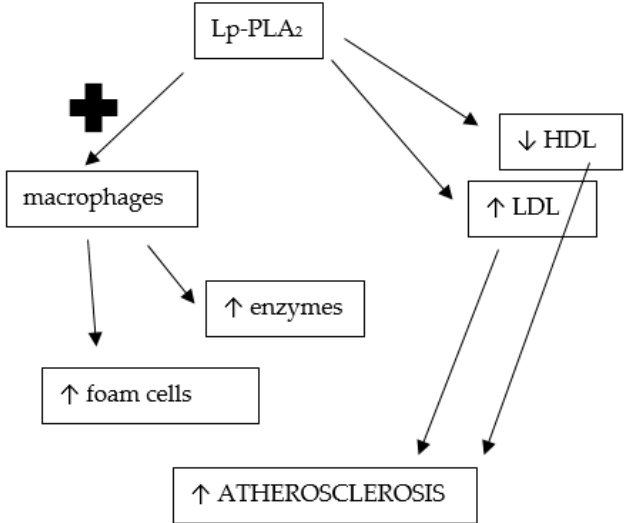
Figure 3. Promotion of atherosclerosis through lipoprotein-associated phosholipase A2 function; Lp- PLA 2 —lipoprotein-associated phosholipase A2, HDL—high-density lipoprotein, LDL—low-density lipoprotein; ↑ — increased; ↓ — decreased.